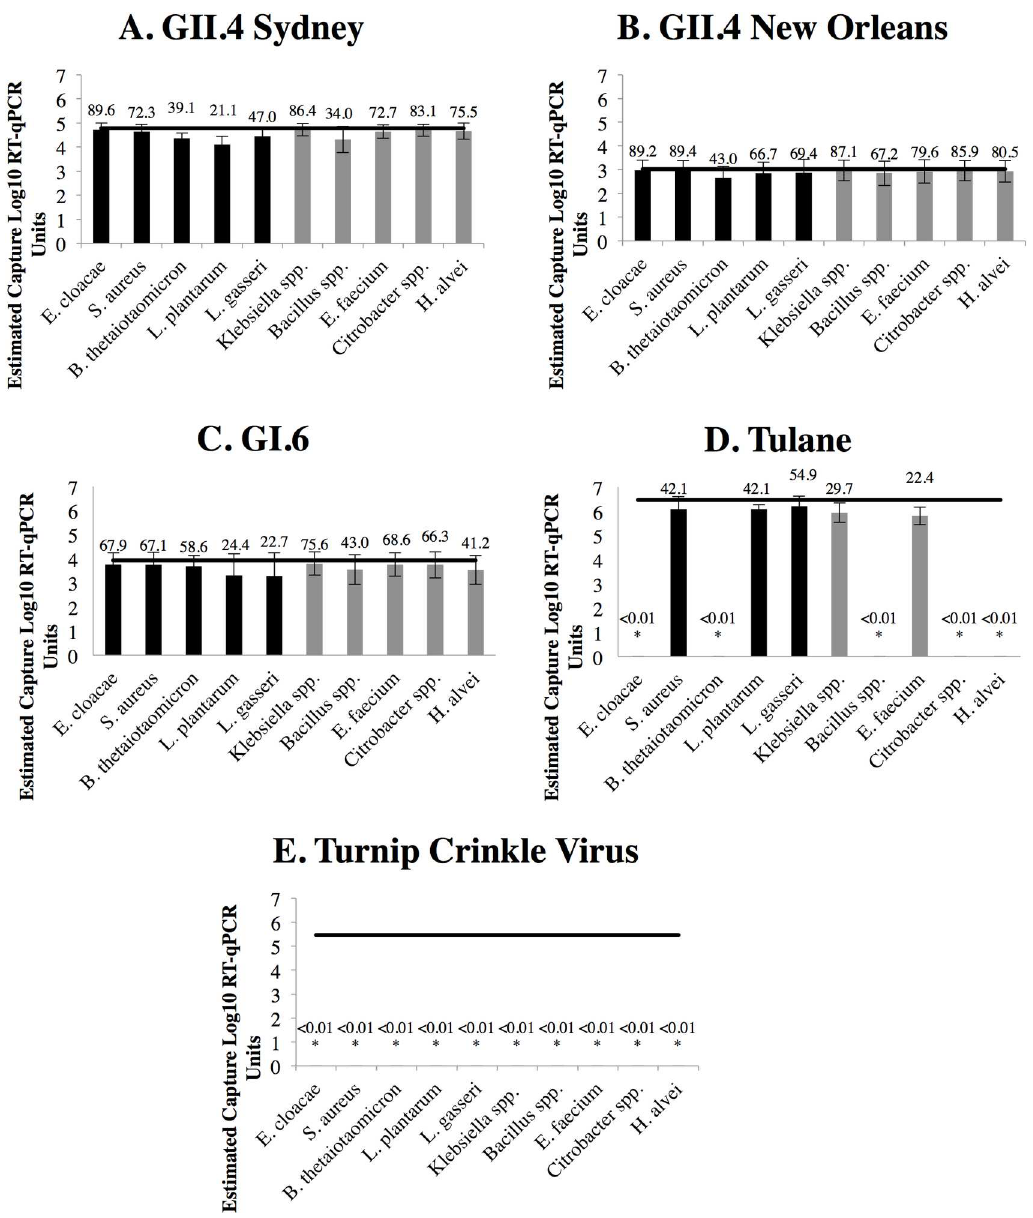
Fig 1. Binding efficiency of human norovirus and representative surrogate viruses to select bacteria. The line indicatesthe total virus input. Data are expressedas log 10 mean concentration ± the standard deviationof bacteria bound(in RT-qPCRU) (bars) and percent bindingefficiency as determinedby loss-to-supernatant ([total input virus- supernatant virus]/total input virus) (numerical).The black bars correspond to ATCC or control strains. The gray bars correspond to bacteriaisolated in this study. All bacteriagrew anaerobically in TSB with the followingexceptions: B . thetaiotaomicron (choppedmeat medium), L . gasseri (MRS) and L . plantarum (MRS). Asterisks ( * ) represent values for which there was a statistically significantdifference (p < 0.05)betweenthe viral input load and the bacterialcapture amount basedon log 10 RT-qPCRU. Data represents averages and standarddeviationsof the assays performed in